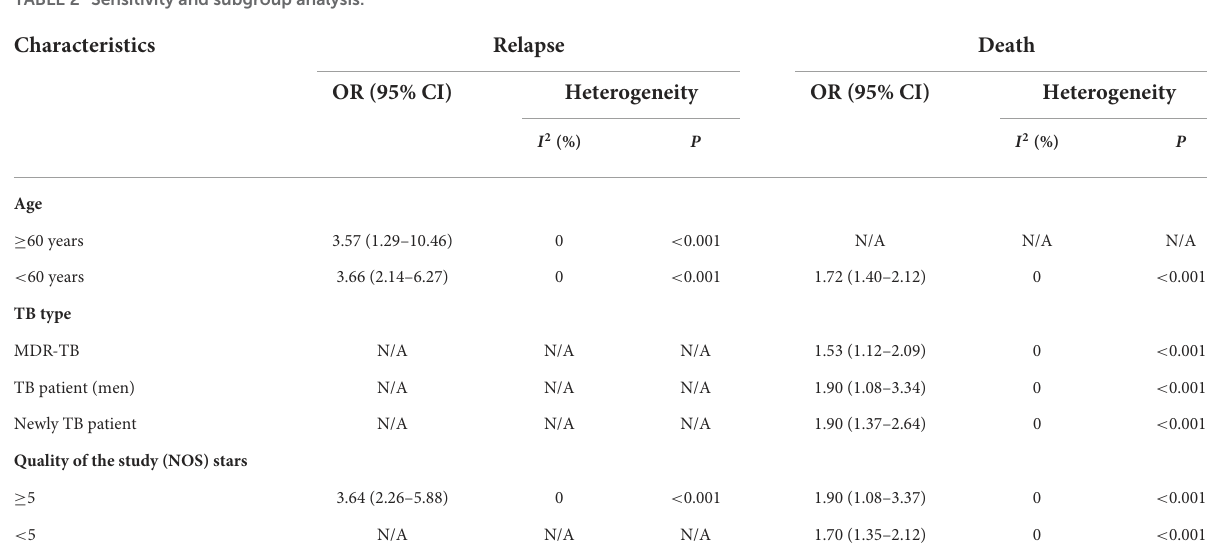
TABLE 2 Sensitivity and subgroup analysis.